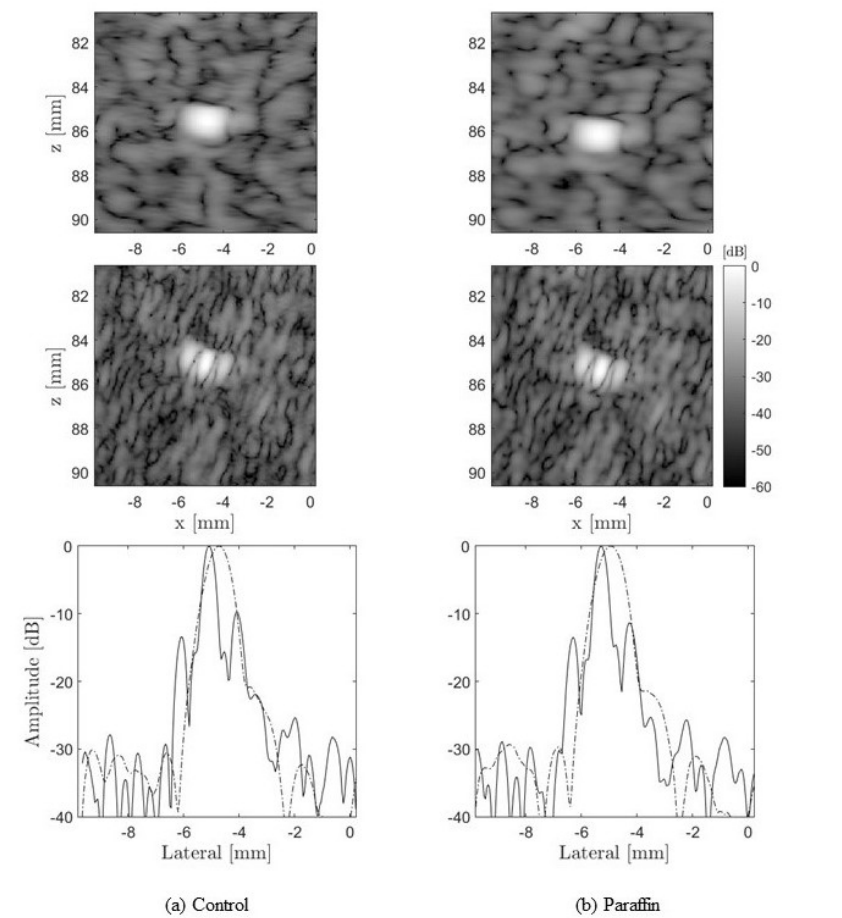
Figure 15. Experimental point target images. Column ( a ) corresponds to the control and column ( b ) to the paraffin. The first row corresponds to the one probe system and the middle row to CoMTUS. The bottom row shows the corresponding lateral point spread functions for the two cases displayed: one probe system (dashed line) and CoMTUS (solid line).